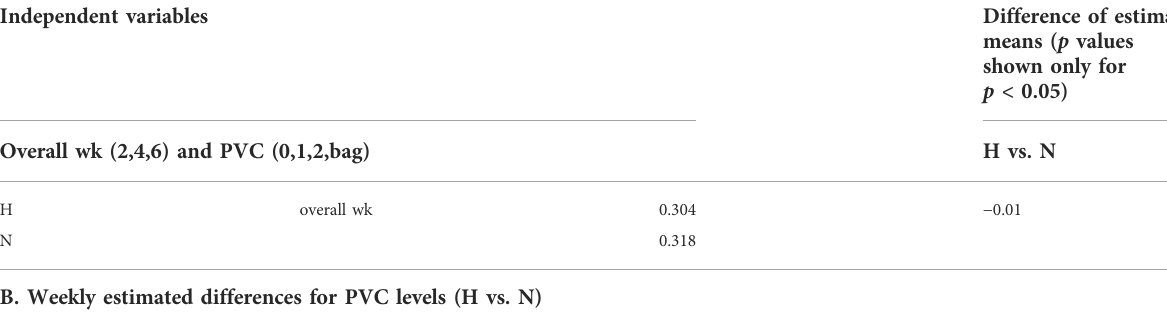
means ( p values shown only for p <